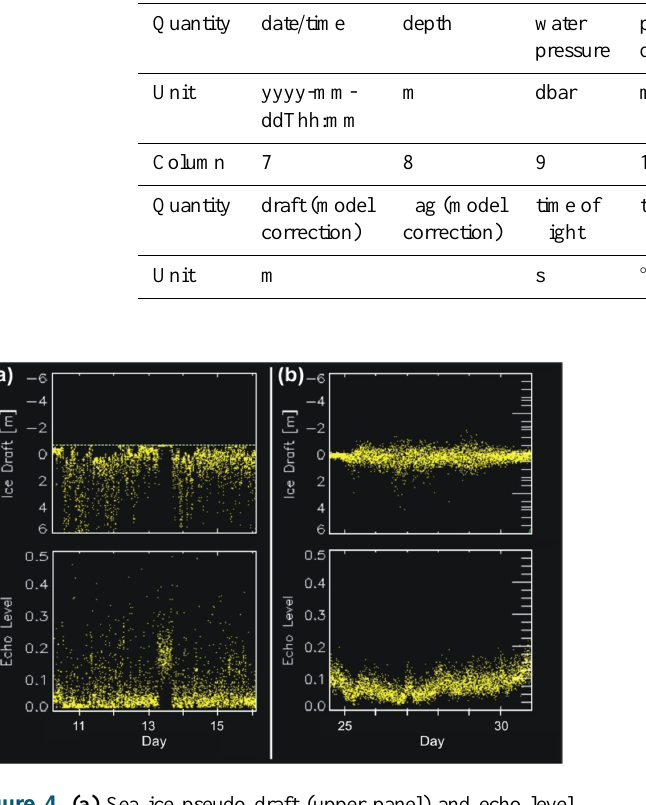
Figure 4. (a) Sea ice pseudo draft (upper panel) and echo level (lower panel) from AWI 232-8 for an ice period in December 2006. Every dot stands for one draft measurement (sample rate: 2min). The true zero level is indicated as dashed line at about − 0.7m. Both the draft data and the echo level display a short period of open water on day 13. (b) Typical appearance of an open water period from AWI 232-8 in January